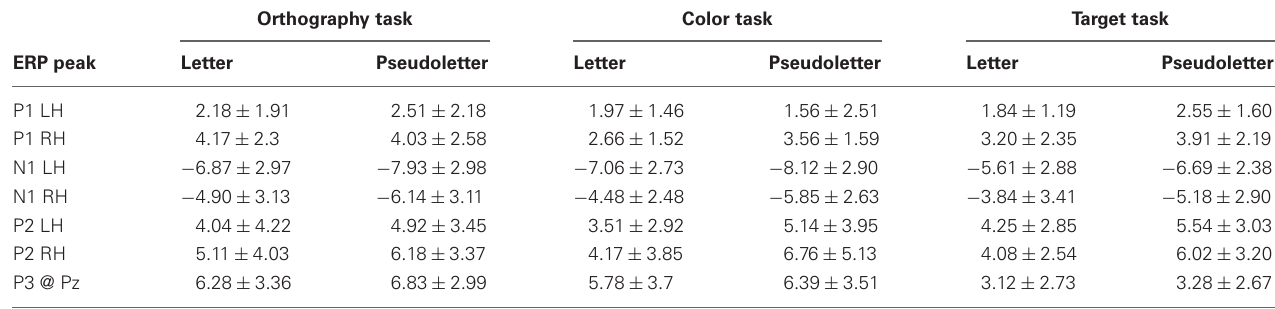
Table 2 | Peak EP amplitudes.